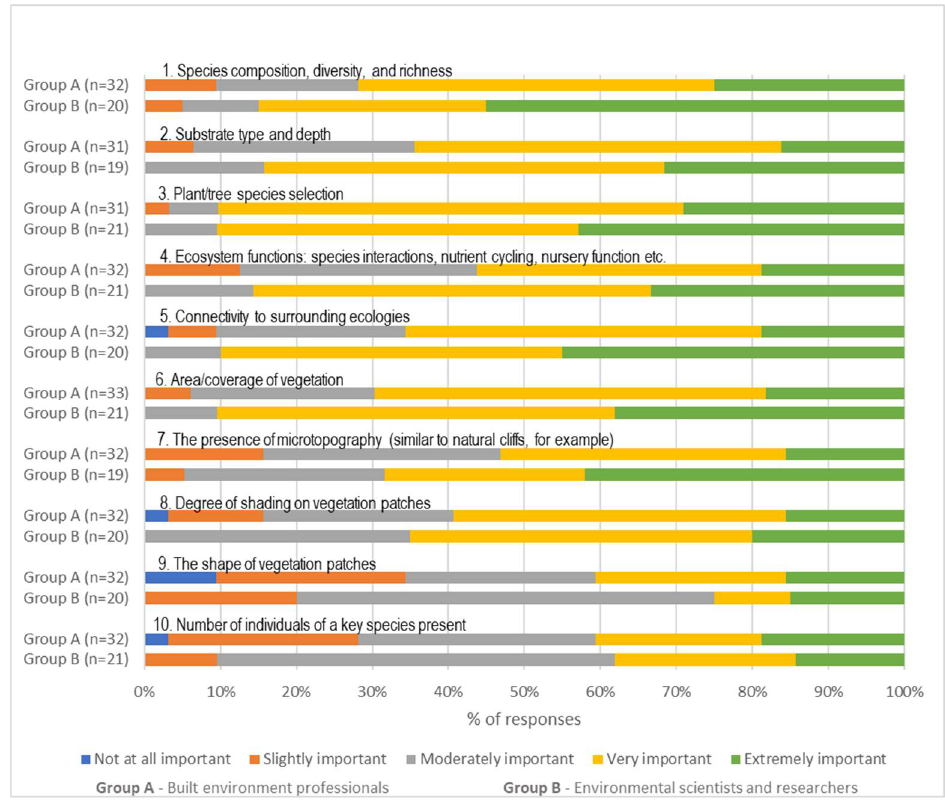
Figure 13. Parameters for assessing building-related habitat provisioning strategies.